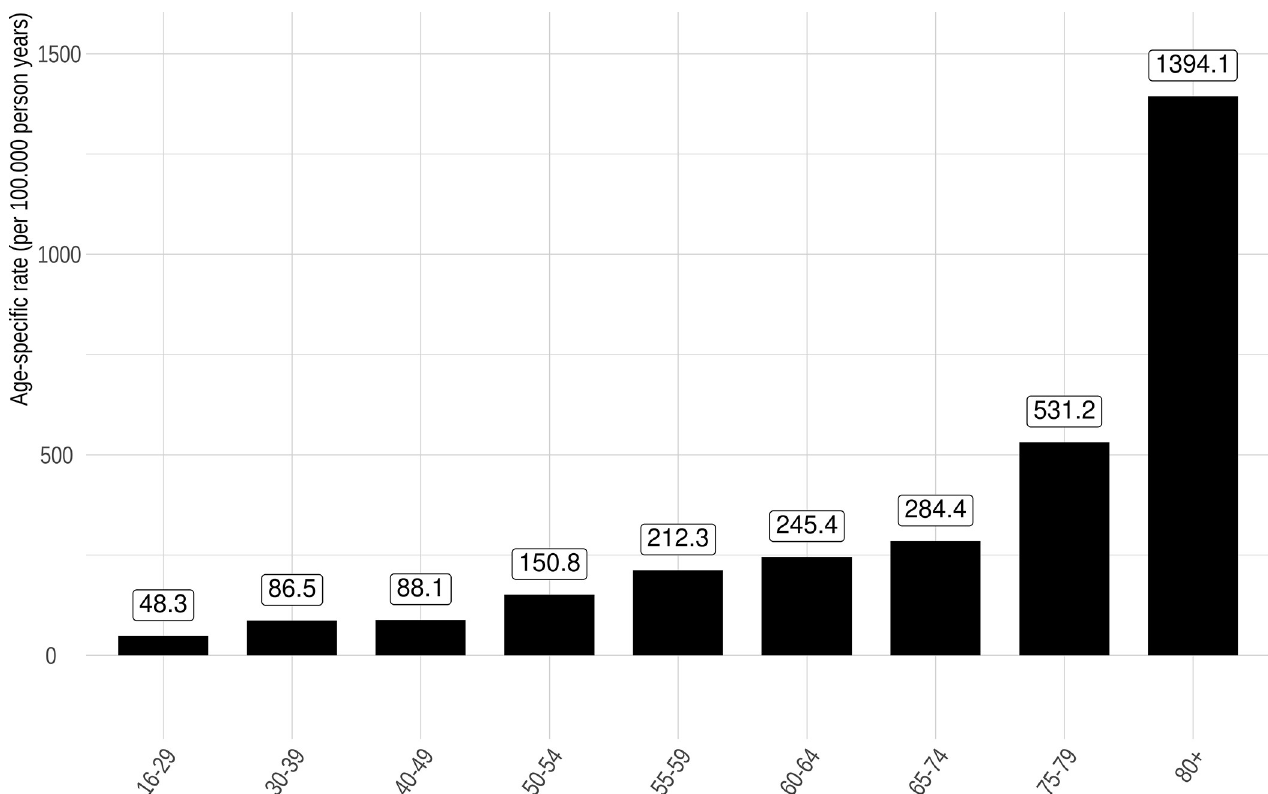
Fig 1. Age-specific rates of COVID-19 hospitalizations in Germany 2020 (per 100.000 person years).